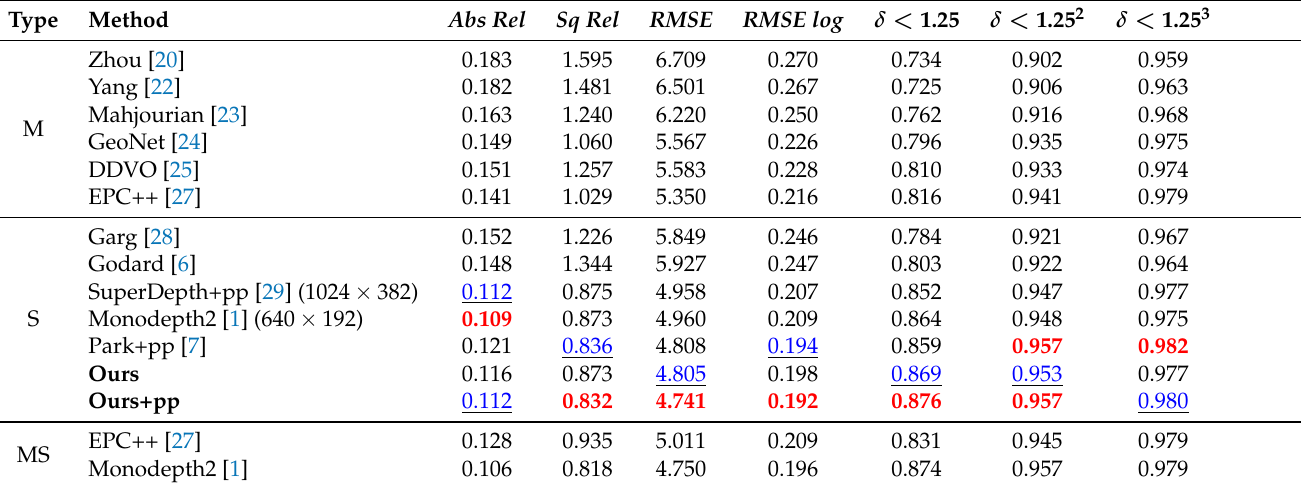
Table 2. Quantitative Results: Comparison with unsupervised learning-based monocular depth- estimation models. Unsupervised monocular depth-estimation models are divided into the following categories: (M) Unsupervised model based on video sequence (Monocular supervision; USI model), (S) Unsupervised model based on stereo images (Stereo supervision; USV model), and (MS): Monocu- lar + stereo supervision.